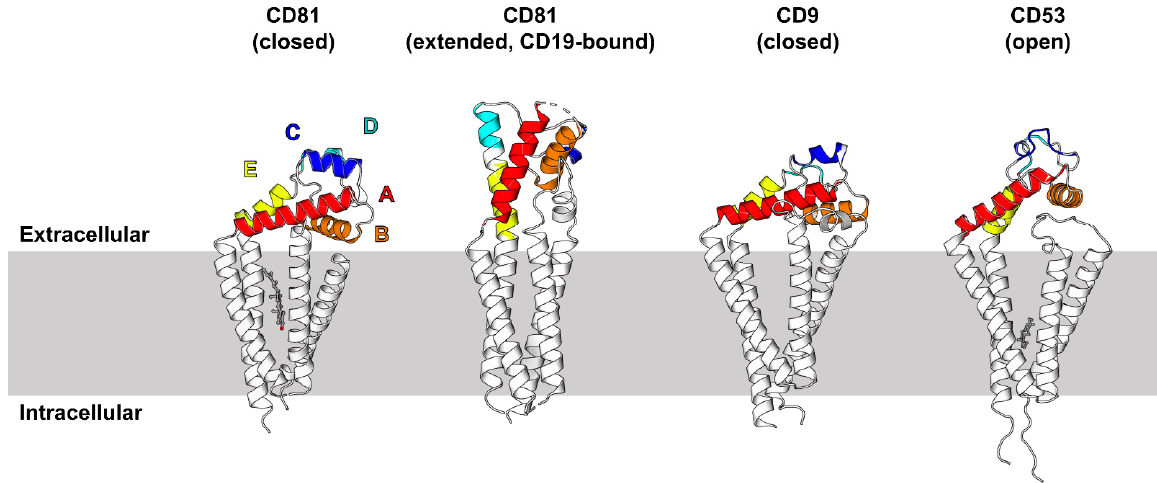
Figure 1. Tetraspanin structures. The helices/loops A–E in the main extracellular region are colored red, orange, dark blue, pale blue, and yellow, respectively. The lipid molecules identified in the intramembrane cavity are shown in grey, namely cholesterol for closed CD81 and monoolein for CD53. Protein Data Bank (PDB) IDs are 5TCX for closed CD81 [38], 7JIC for extended CD19-bound CD81 [39], 6K4J for CD9 [40], and 6WVG for CD53 [41].